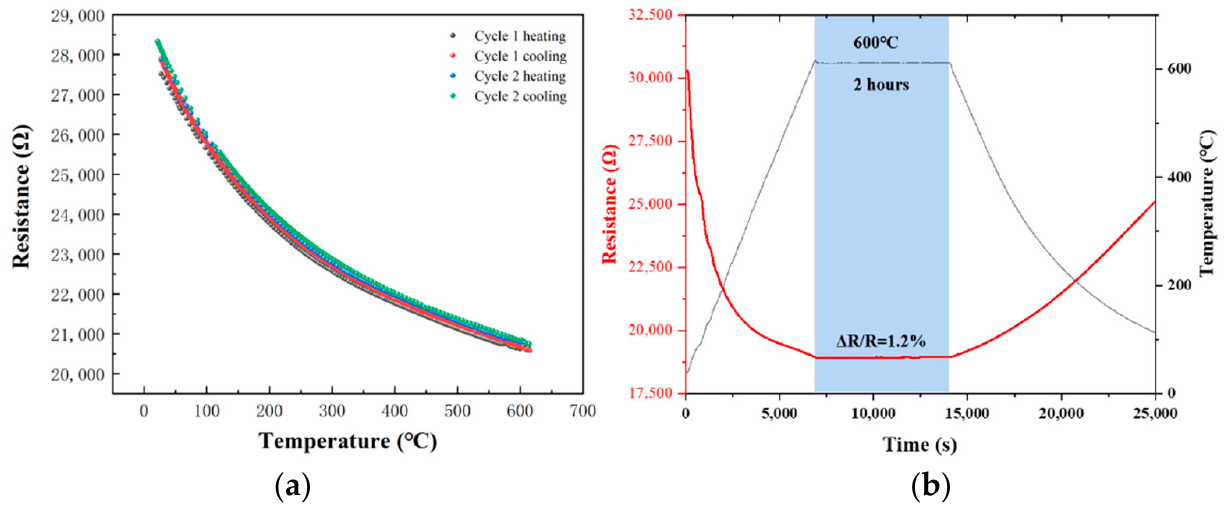
Figure 8. ( a ) R–T curves of ZrB 2 (60 wt%)/SiCN TFSG from room temperature to 600 ◦ C; ( b ) Resistance change curves of ZrB 2 (60 wt%)/SiCN TFSG at 600 ◦ C for 2 h. To evaluate the strain response of ZrB 2 (60 wt%)/SiCN TFSG at high temperatures, cyclic strain tests were carried out from room temperature to 600 ◦ C, as shown in Figure 9a. The curves of the cyclic strain response were intercepted at 400 ◦ C, 500 ◦ C and 600 ◦ C, respectively, as shown in the Figure 9b–d. ZrB 2 (60 wt%)/SiCN TFSG exhibits good re- peatability and stability resistance at high temperatures. Although the overall resistance decreases with increasing temperature due to the temperature-resistance effect, the pulse signal caused by the cyclic strain is clearly visible. The above high-temperature test results show that ZrB 2 (60 wt%)/SiCN TFSG has good resistance stability and highly sensitive strain response in the temperature range from room temperature to 600 ◦ C, and has poten- tial application in the field of hot component strain